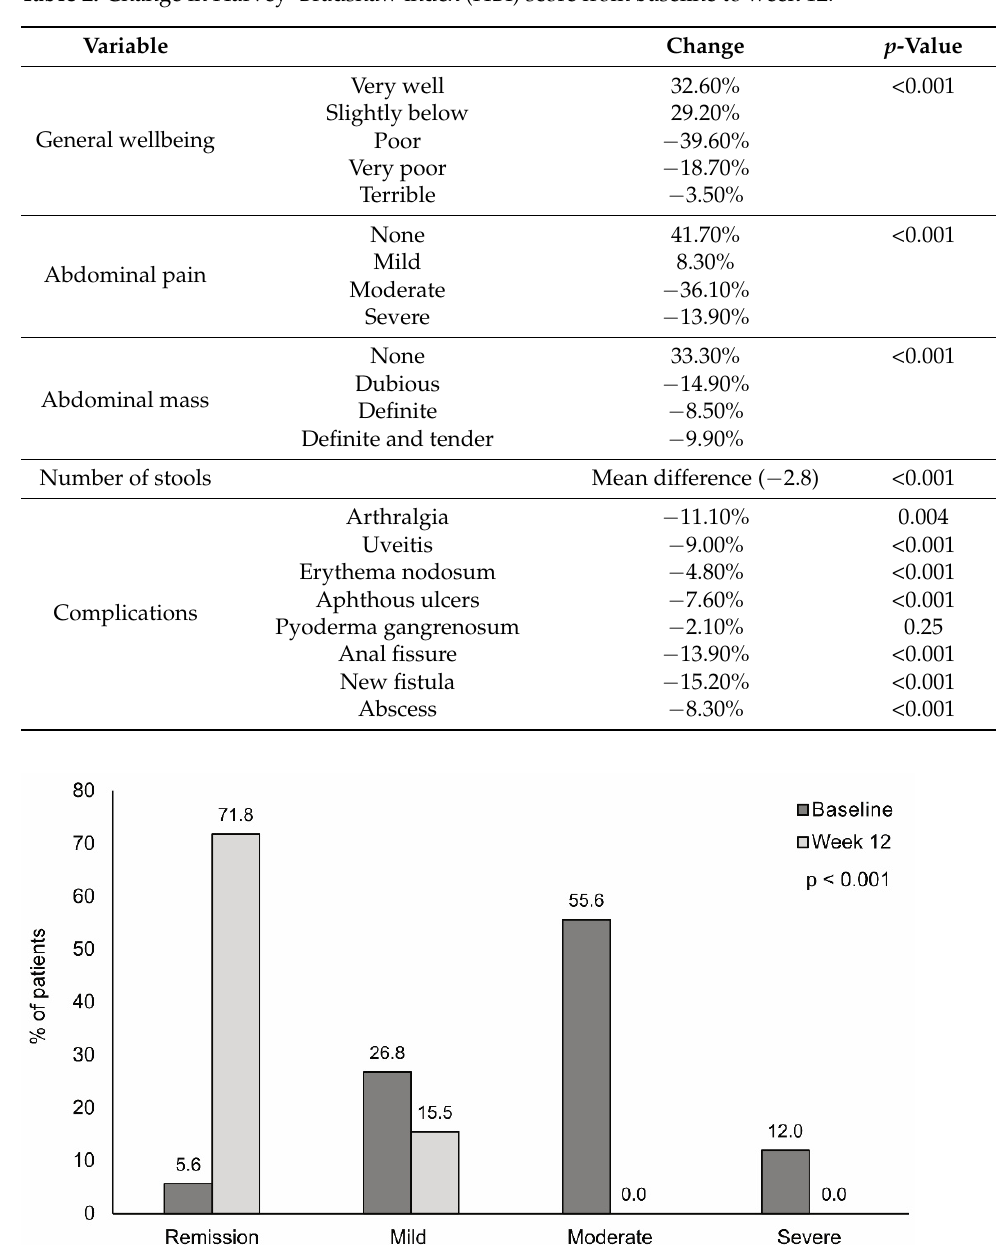
Figure 3. Change in Harvey–Bradshaw index (HBI) after 12 weeks of treatment with a semi-elemental hydrolyzed whey protein diet. Bar graphs show the proportion of patients in remission, and with mild, moderate, or severe disease activity at baseline and after 12 weeks of treatment. The change in HBI was statistically significant ( p < 0.001). Table 2. Change in Harvey–Bradshaw index (HBI) score from baseline to week 12.